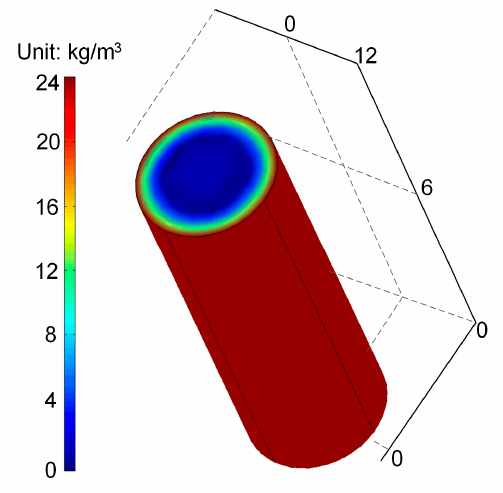
Figure 1. Simulation result of total chloride content distribution after servicing for 50 years.